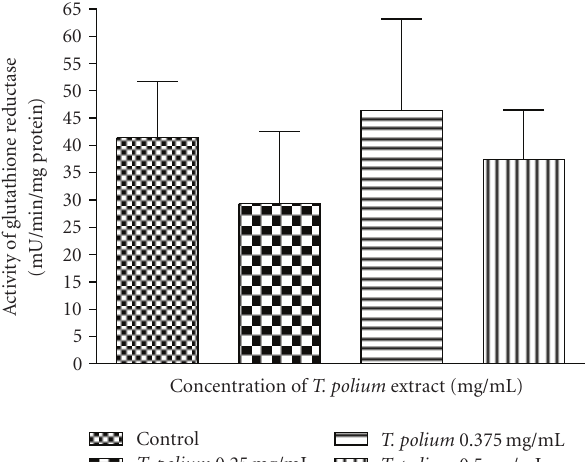
Figure 6: E ff ect of a 24-hour exposure of an aqueous extract of T. polium on glutathione reductase activity in HepG2 cultured cells. Data are presented as mean ± standard deviation. Sample size ( n ) =